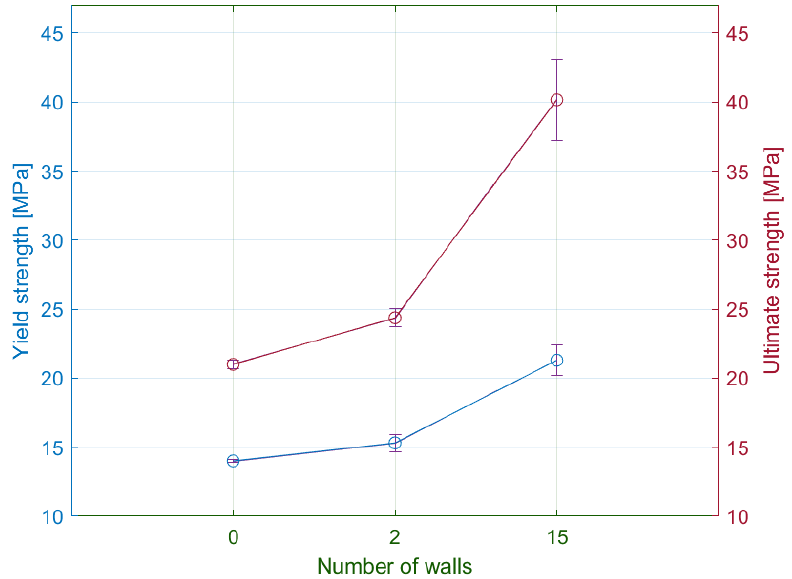
Figure 17 . Comparison of measured average values of yield strength and ultimate strength for the selected wall number.